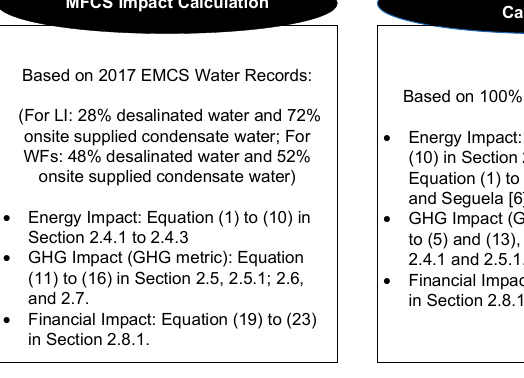
Figure 5. Summary of the energy, environmental and financial impact calculations.